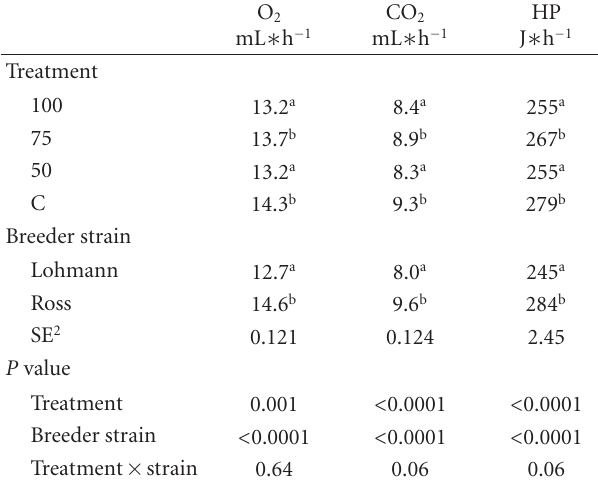
Table 1: Total oxygen consumption (O 2 ), carbon dioxide pro- duction (CO 2 ), and heat production (HP) of layer (Lohmann- Lo) and broiler (Ross-Ro) hatchlings in ovo injected with di ff erent concentrations of AgNano (50, 75, and 100 mg/kg) and the control (no-injection, C) measured at embryonic days 13 to 19 1